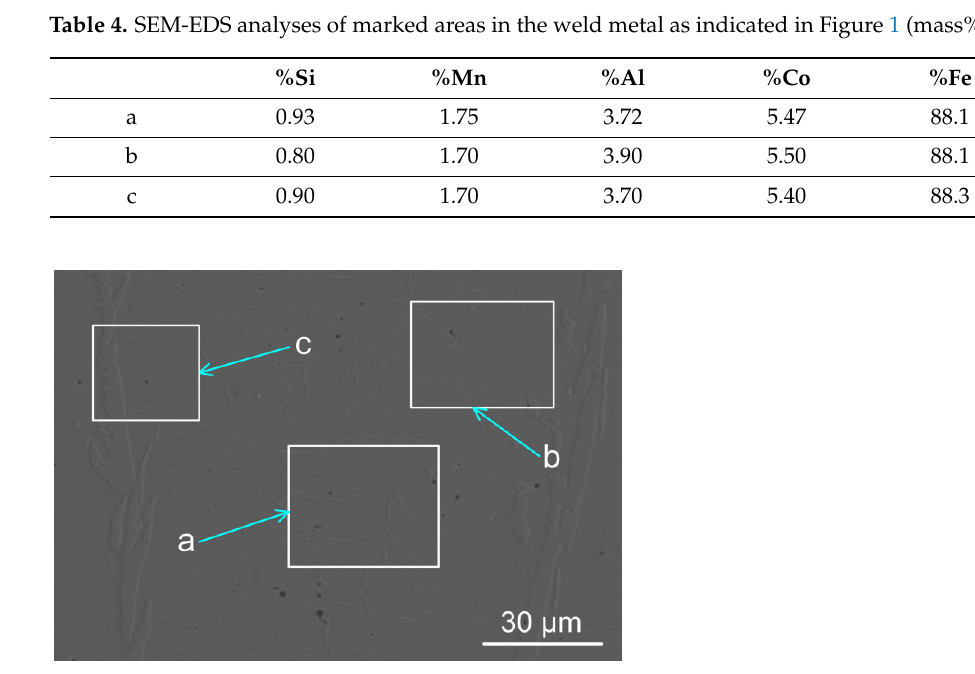
Figure 1. SEM micrograph of weld metal with analysed areas as marked (a–c): (×2000). Table 4. SEM-EDS analyses of marked areas in the weld metal as indicated in Figure 1 (mass%).